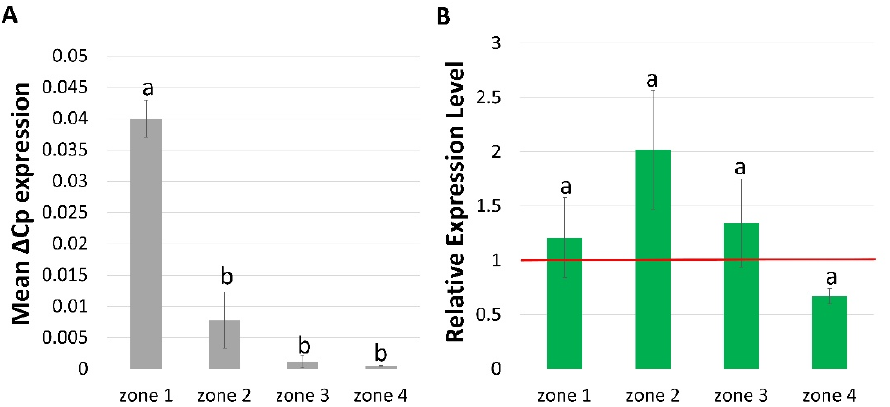
Figure 7. Expression profile of HvCSLC3 gene in ( A ) four root zones of WT cv. ‘Sebastian’ ( B ) four root zones of rhp1.e mutant normalized to the gene expression level in the corresponding zones of WT, which was considered as the value 1 (red line). Root zones: 1—meristematic, 2—elongation, 3—differentiation and 4—developed root hair zone. Different lowercase letters indicate the significant differences between analyzed root zones in WT ( A ) and mutant ( B ) according to the one way ANOVA, Tukey’s HSD test ( p < 0.05). Graph shows mean values of n = 3 with